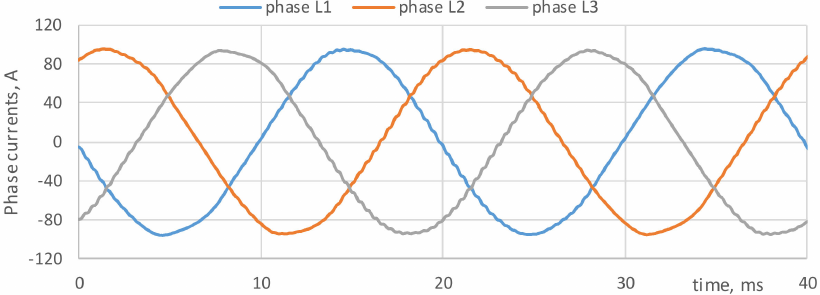
Figure 20. Exemplary MV phase current waveforms for the photovoltaic power station for generated active power equal to 700 kW.